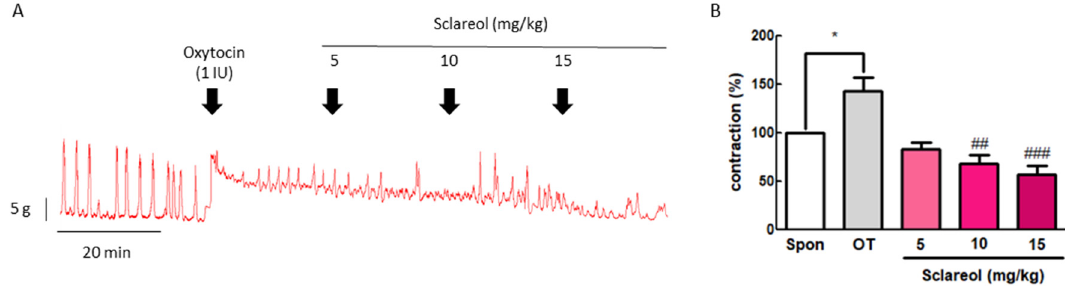
Figure 2. Effect of sclareol on oxytocin-induced uterine contraction in vivo and its possible mechanism. ( A ) Effect of sclareol (5, 10, or 15 mg/kg) on oxytocin-induced (1 IU) uterine contractions in vivo. The rats were ip injected with oxytocin combined with sclareol (5, 10, or 15 mg/kg), and the contractions were recorded. ( B ) The effects of sclareol on the mean peak amplitude. * p < 0.05 compared to spontaneous contraction (Spon), ## p < 0.01 compared to oxytocin, ### p < 0.001 compared to oxytocin. Each column represents the mean ± SEM; n = 7.